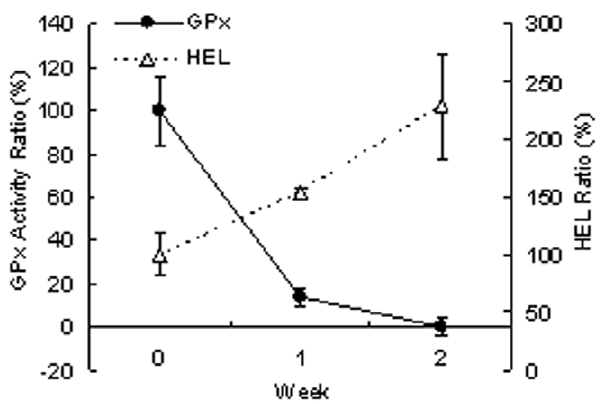
Figure 3. Effect of selenium deficiency on CEPI cells. Selenium deficiency-induced GPx activity and HEL production in CEPI cells. Open triangle shows the ratio of GPx activity and closed cycle shows ratio of HEL content. Data are mean 6 S.D. (n=6).